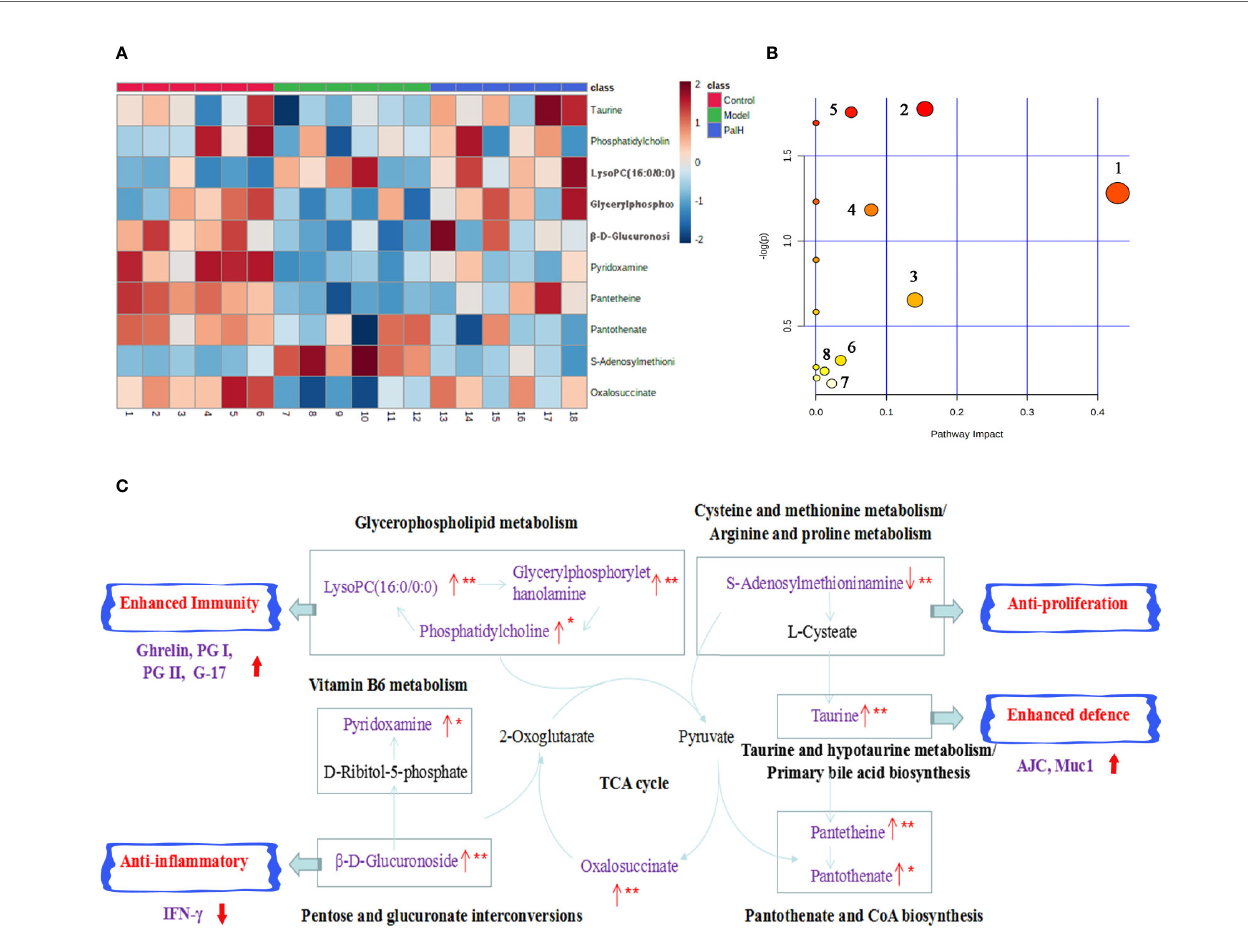
FIGURE 11 | Pathway analysis of Pal treatment. (A) The heatmap of 10 potential metabolites. (B) Metabolomic pathway construction of the metabolic pathways involved in the effects of Pal on chronic atrophic gastritis (CAG). (C) Signaling networks associated with the differentially expressed metabolic pathways. Red represents the detected metabolite.